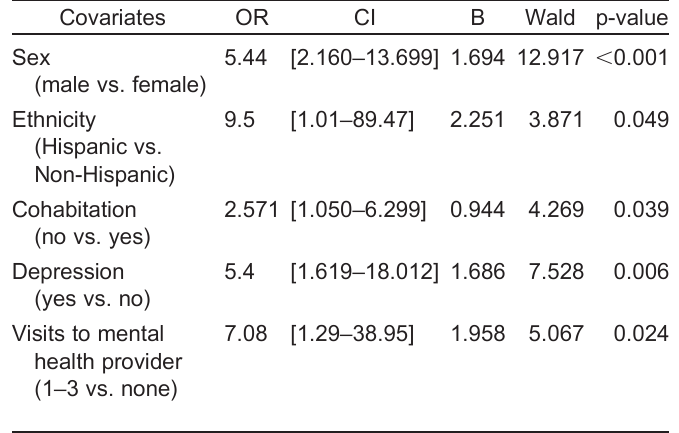
Table 3. Logistic regressions and predictors for positive elder mistreatment screen.